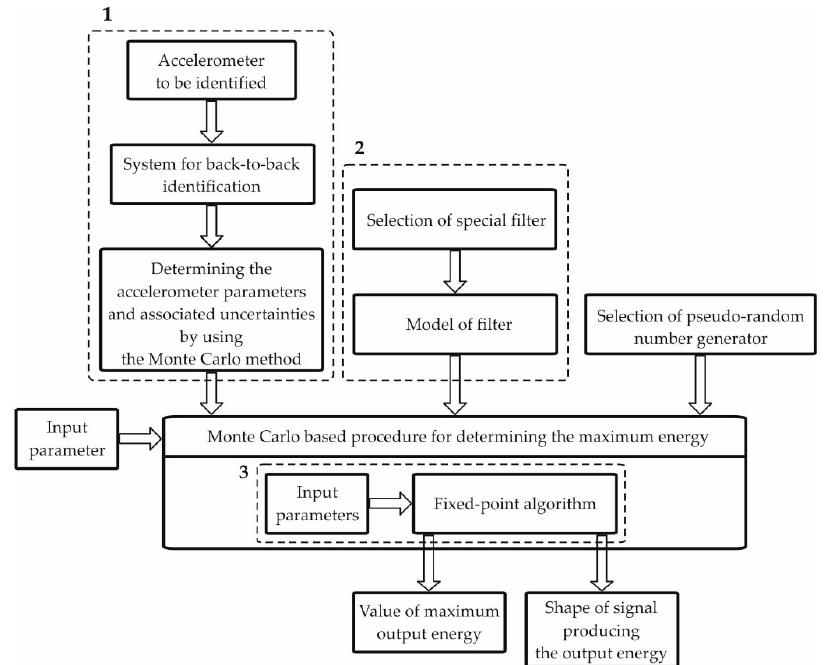
Figure 5. Block diagram of Monte Carlo-based procedure for determining the ME at the output of the accelerometer.